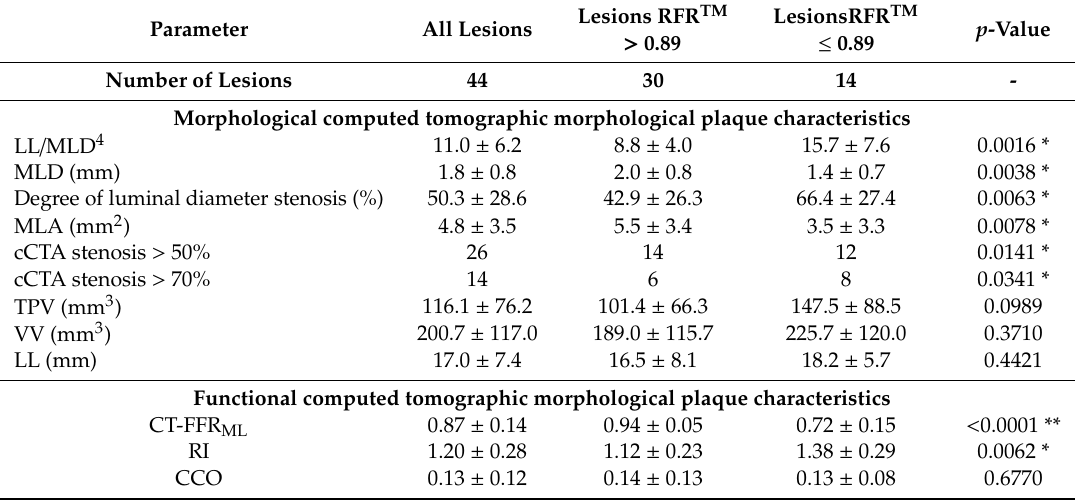
Table2. ComparisonofCT-FFR ML andplaquecharacteristicsinstenosiswithandwithouthemodynamic relevance stenosis using RFR TM as